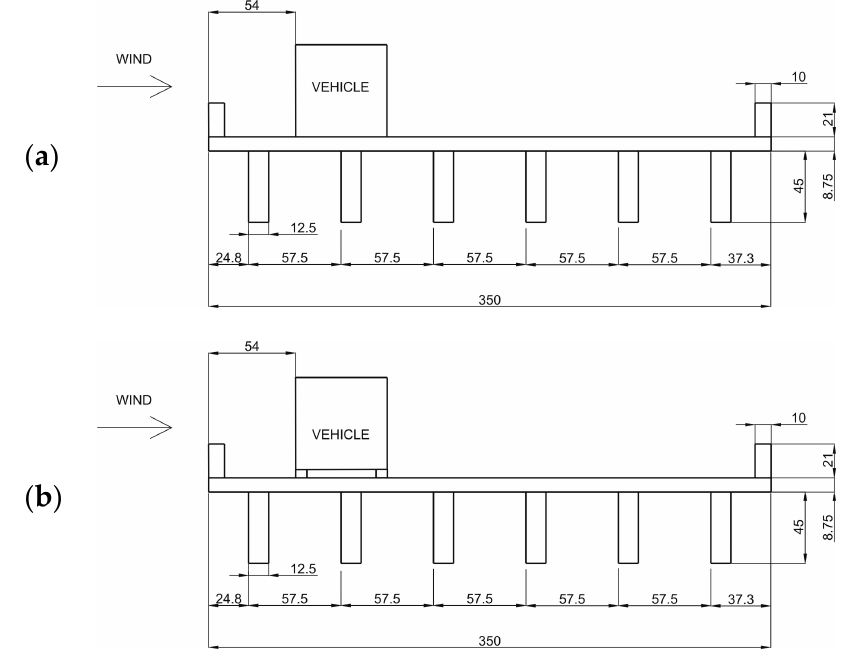
Figure 1. TFFS models (all dimensions in mm): ( a ) van model without wheels (model A) and ( b ) van model with wheels (model B); in both configurations, van models are placed on a 1 m long bridge-deck section model; adapted from Kozmar et al. [5].